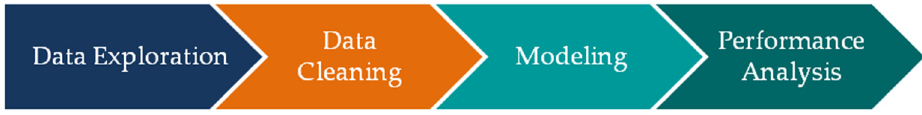
Figure 1. Steps involved in the predictive analysis.